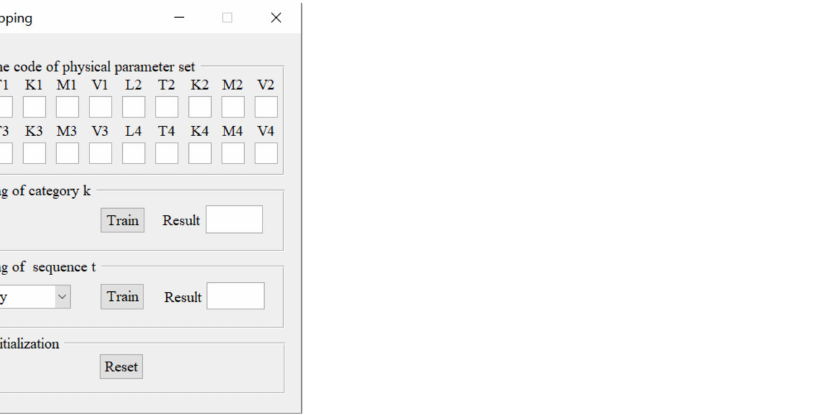
Figure 7. Calling module of the mapping model between physical parameters and engineering parameters.